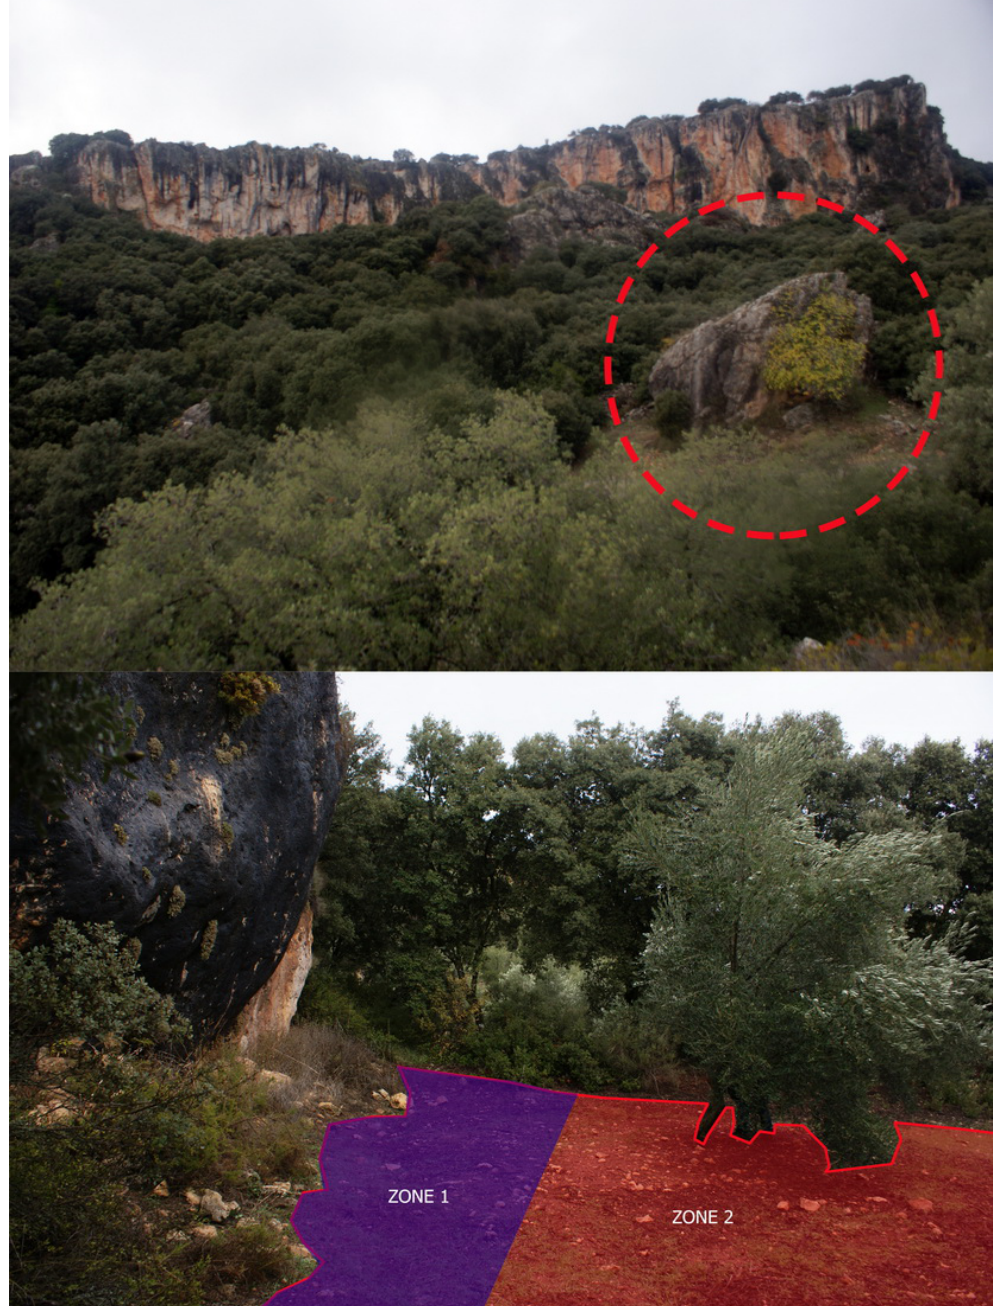
Figure 2. Location by zones of recovery of the archaeological